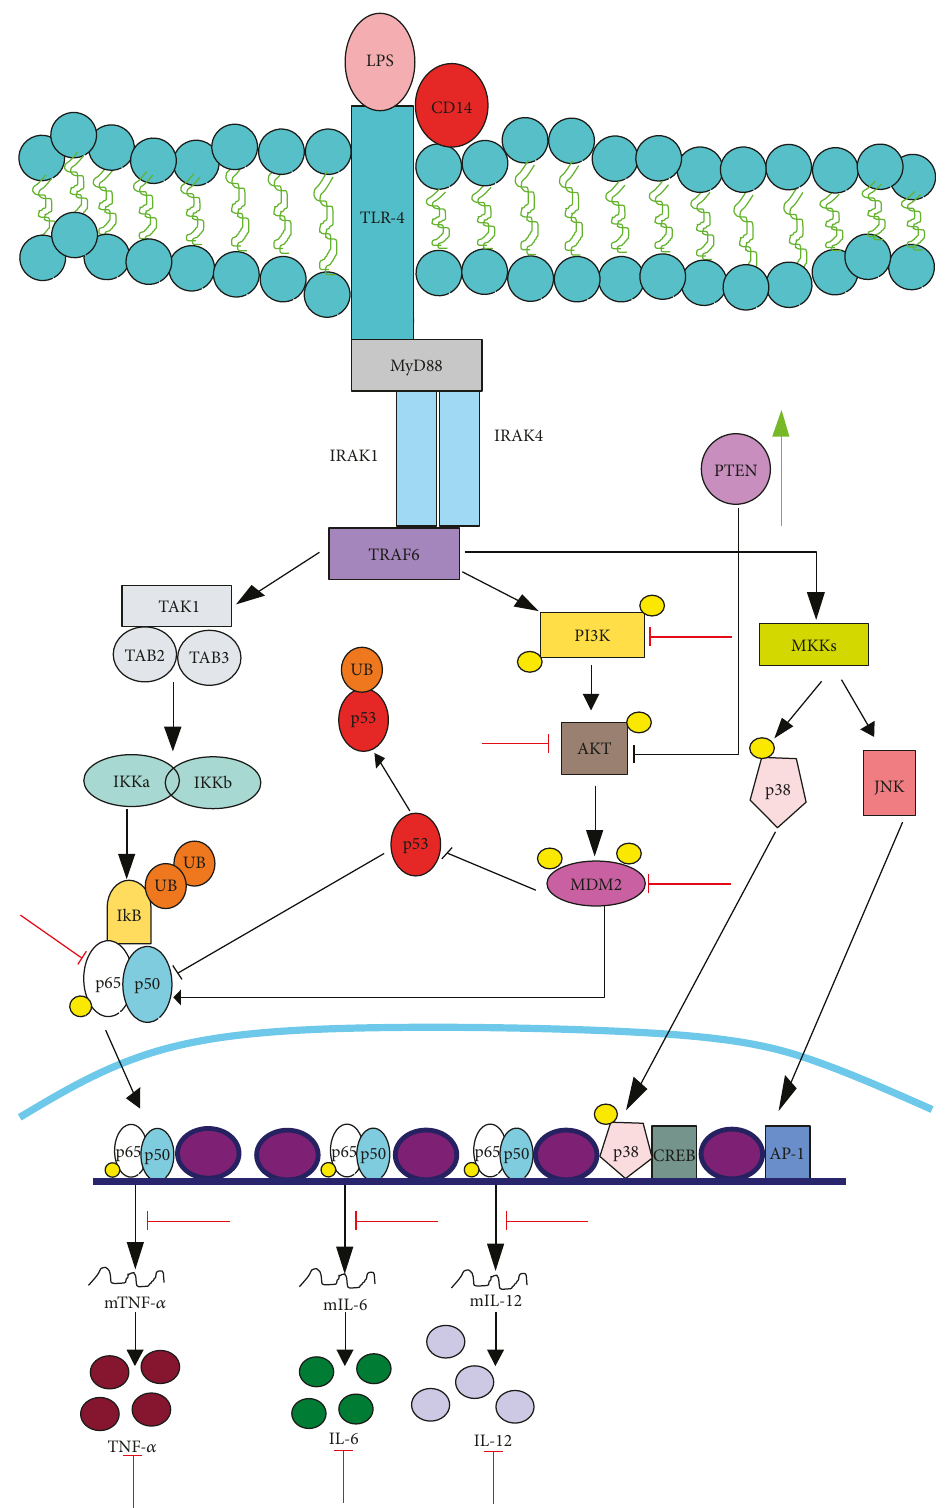
Figure 1: VPA inhibits LPS signaling in macrophages. VPA inhibits the production of proin fl ammatory cytokines (IL-6, IL-12, and TNF- α ) after stimulation with LPS by a ff ecting the phosphorylation of NF- κ B, PI K, Akt, and MDM2. Therefore, there is an increase in the levels of 3 the NF- κ B inhibitor p53 and in the levels of the negative regulator of Akt, PTEN. Green arrows indicate the processes, molecules, or mediators in the signaling pathway that are augmented and/or promoted by VPA. Red arrows indicate processes, molecules, or mediators in the signaling pathway that are inhibited by